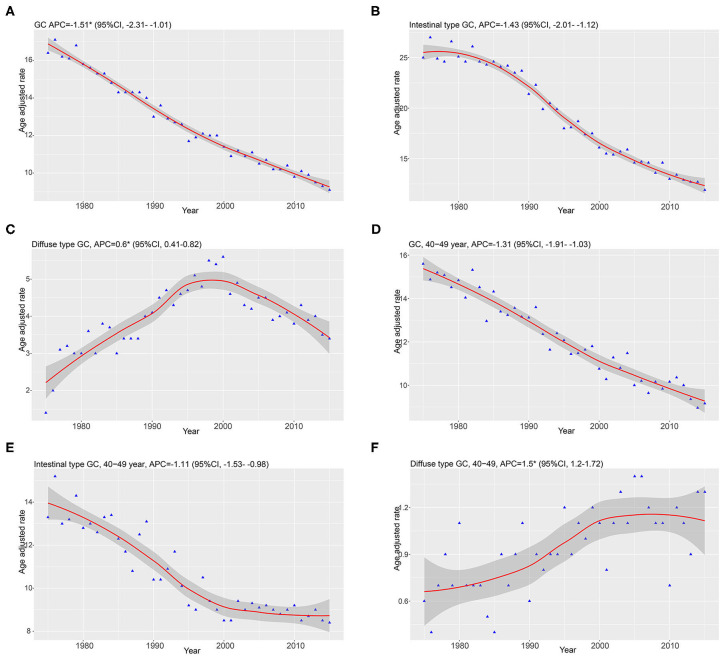
Data are from the Surveillance, Epidemiology, and End Results program and were age-standardized to the 2,000 US standard population. Smooth lines represent fitted piecewise–log linear trends. Annual percentage changes (APCs) with parametric confidence intervals were calculated. (A–C) Represented the trends of GC, diffused type, and intestinal type. (D–F) Showed the trends of GC, diffused type, and intestinal type diagnosed at 40–49 years of age.